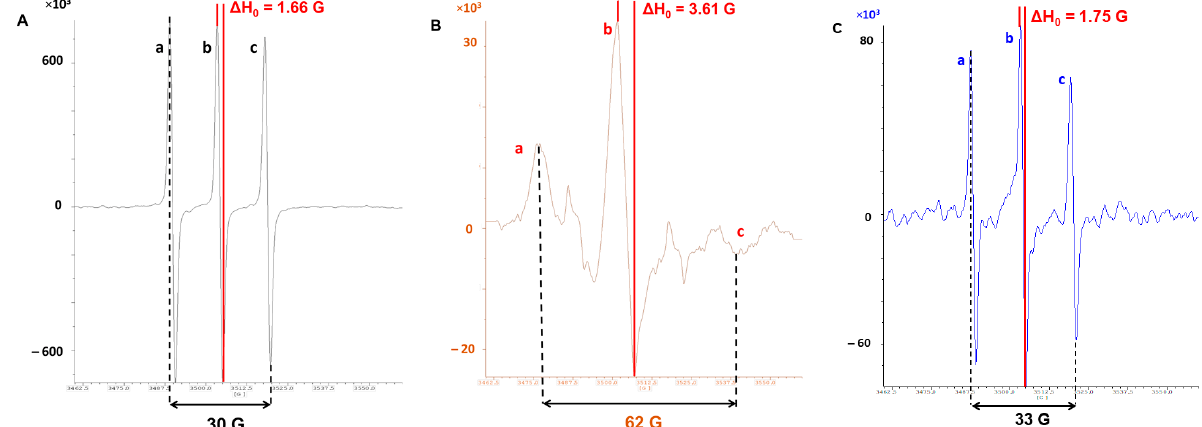
Figure 6. Spectra of 3-Maleimido-PROXYL radical (200µM) after incubation for 120 min. ( A ) Control of 3-Maleimido-PROXYL/DMSO without serum (in black); ( B ) 3-Maleimido-PROXYL in serum samples of healthy patients (in red); and ( C ) spectra of 3-Maleimido-PROXYL in serum samples of patients with COVID-19 (in blue). ( A ) EPR spectra of 3-Maleimido-PROXYL in DMSO. The observed spectrum is due to the free rotation of the radical and is represented by the typical nitroxide triplet; ( B ) EPR spectra of 3-Maleimido-PROXYL in healthy controls. At albumin concentrations above 3.5 g/dL, immobilization of spin-marker rotation is observed due to the attachment of the nitroxide to the protein. In clinically healthy subjects, EPR values were twice as high as with 3-maleimido-PROXYL/DMSO, which may be due to high levels of reduced HSA; ( C ) the spectrum of 3-Maleimido-PROXYL in patients with COVID-19. The spectrum is identical and comparable to that of the radical in DMSO. The EPR parameters A max and Δ H 0 (Table 4) measured in patients with coronavirus infection are close in values to 3-Maleimido-PROXYL/DMSO, probably due to low serum albumin levels and a high degree of oxidized HSA. High levels of oxidized albumin and hypoalbuminemia in severe COVID-19 patients suggest free rotation of 3-Maleimido-PROXYL comparable to that of the nitroxide in DMSO (a protein-free sample).